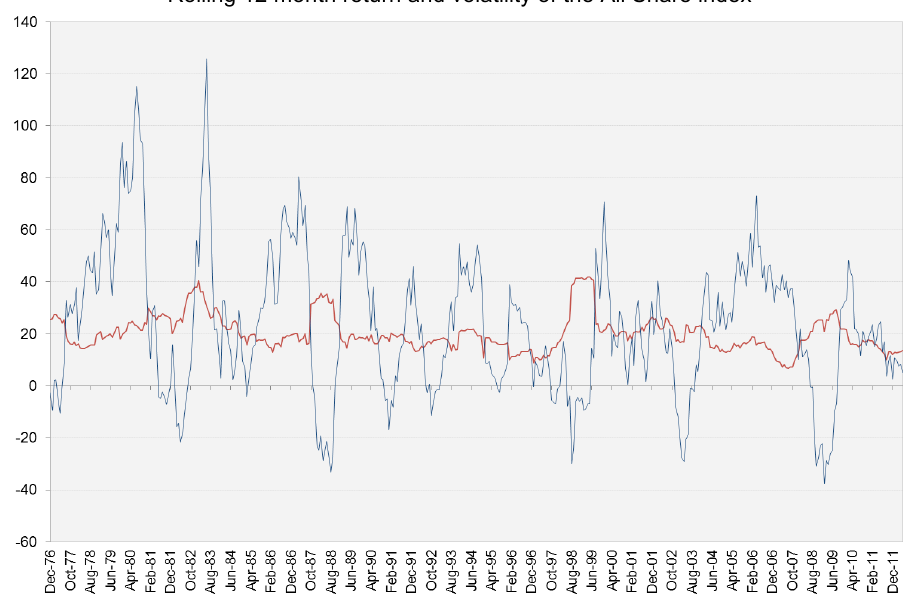
Rolling 12 month return and volatility of the All Share